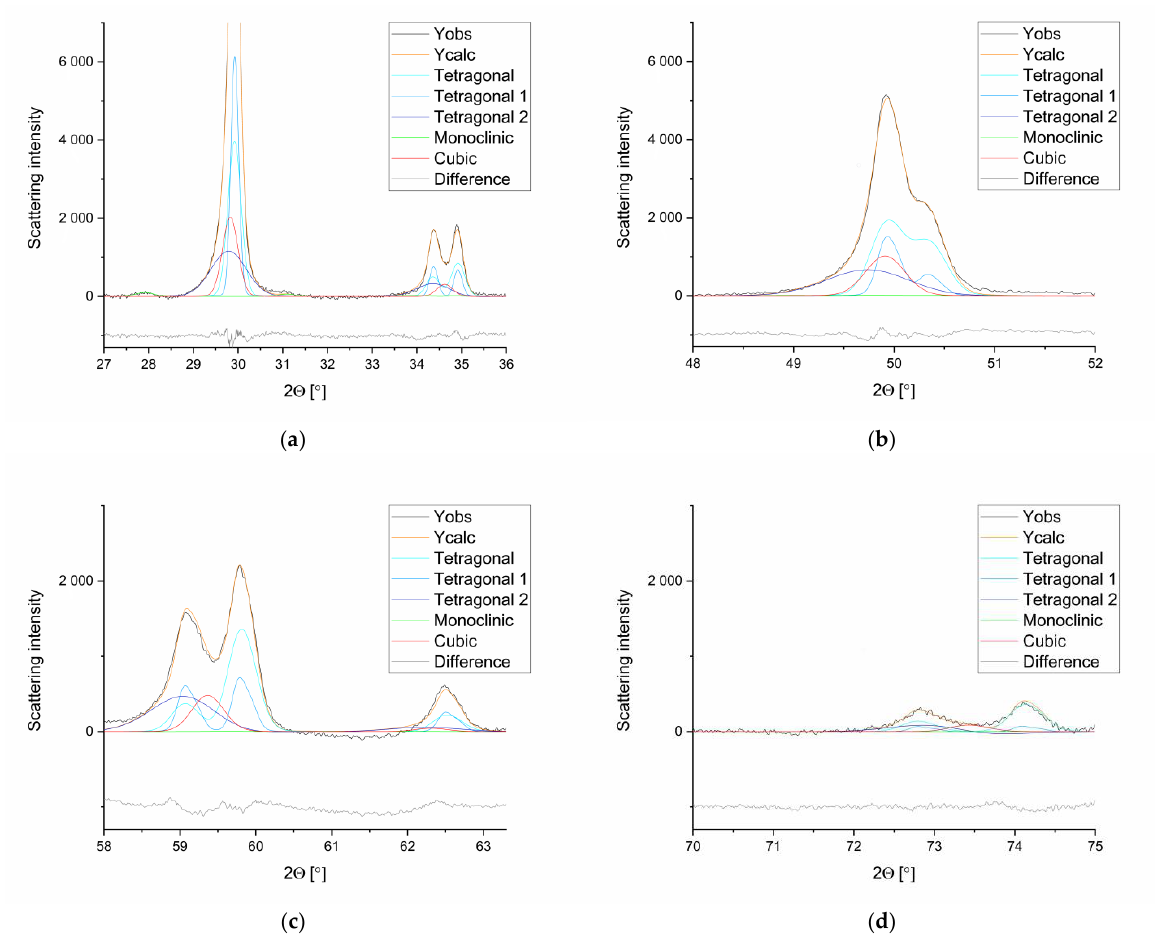
Figure 3. Comparison of the different calculated phases, the observed graph (Yobs), the refined graph (Ycalc), and the difference between Yobs and Ycalc (used sample: 3y_PM (1)B). ( a ) 27–36 ◦ , ( b ) 48–52 ◦ , ( c ) 58–64 ◦ , ( d ) 70–75 ◦